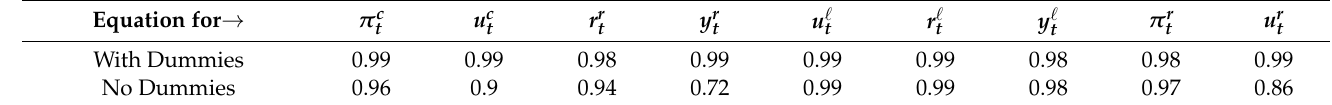
Table A1. Correlation Between Fitted and Actual Values: Sensitivity to Covid Dummies.